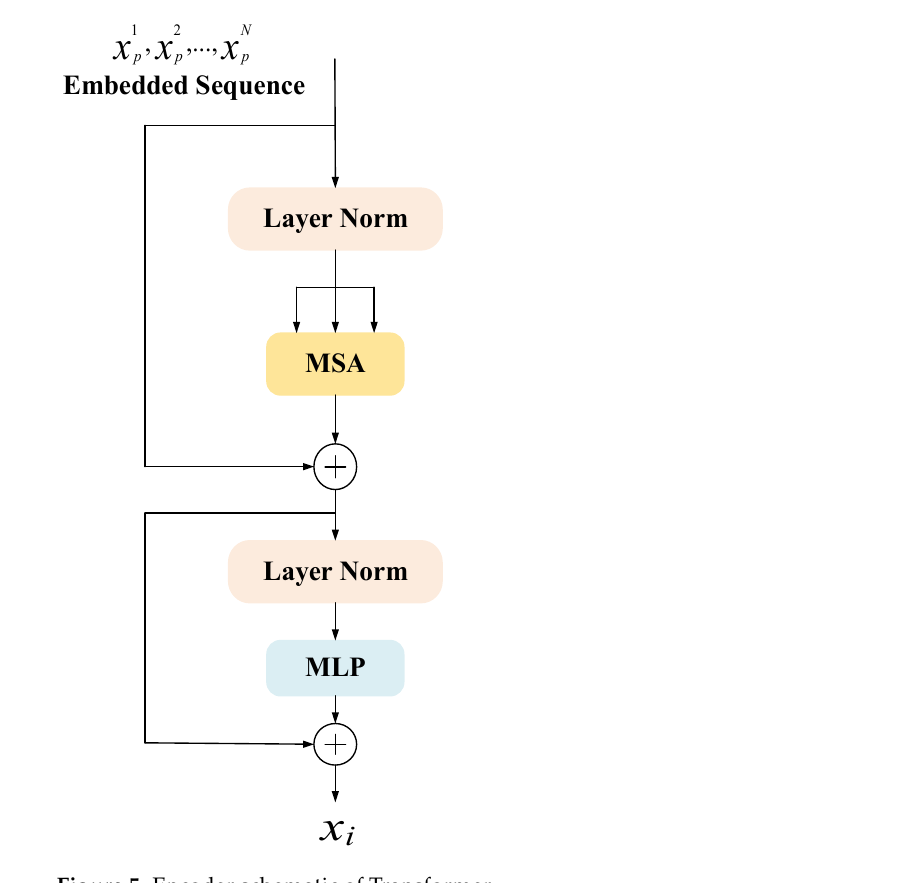
Figure 5. Encoder schematic of Transformer.